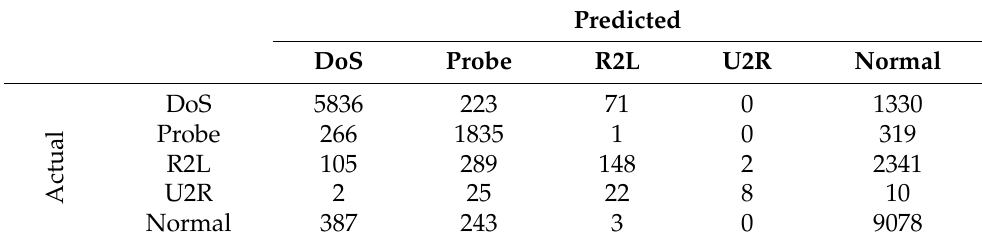
Table 10. Confusion matrix for NSL-KDD “full features” multiclass classification experiment.